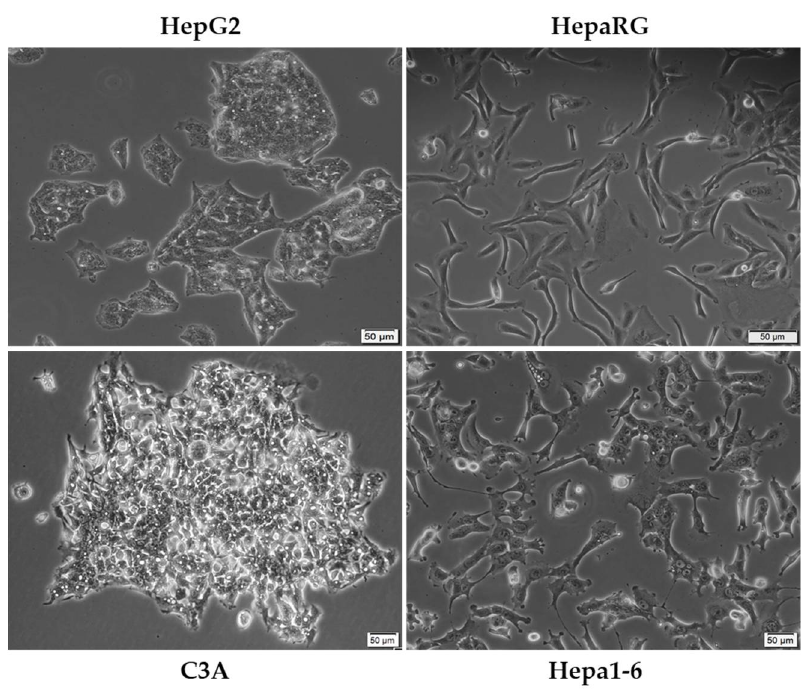
Figure 4. Morphological aspect of some of the most frequently used cell lines as in vitro models for HCC of human (HepG2, HepaRG, and C3A) and murine (Hepa1-6) origin. The scale bar represents 50 µM. Table 1. Presentation of the cell lines currently described in the literature as established in vitro experimental models for HCC. Sensitivity to HCC Frequency Cell Origin Disease Chemotherapy (So- (No. of Pub- Applications Line rafenib) Med Studies) HepG2